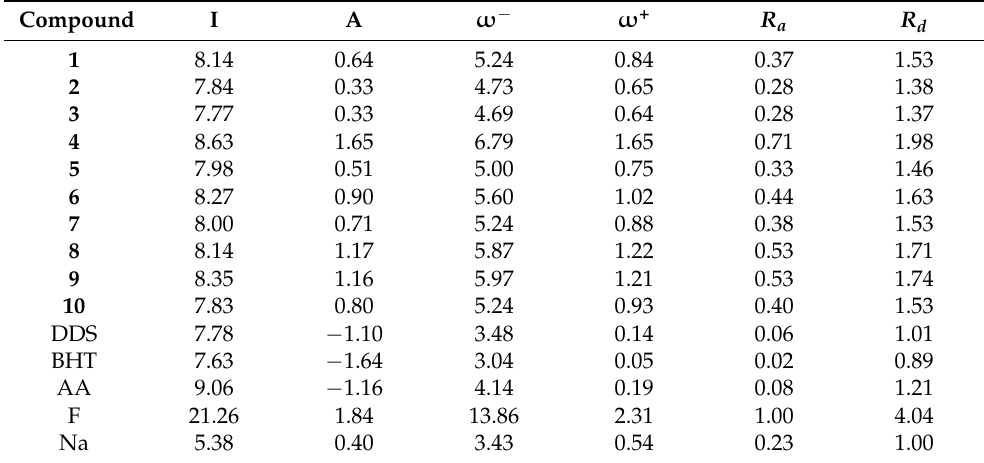
Table 5. Molecular descriptors calculated for DDS and its derivatives at a CAM-B3LYP theory level and 6-311G (d,p) basis set. Values in